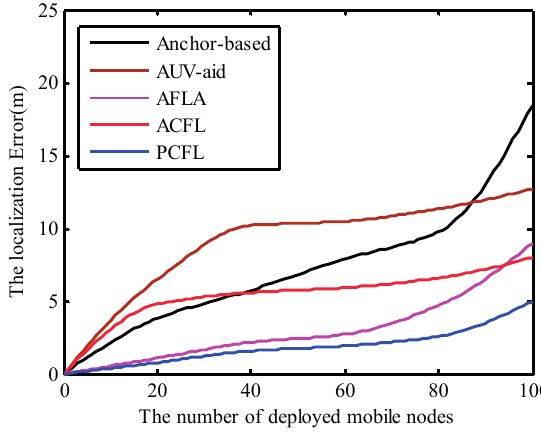
Figure 13. The number of deployed mobile